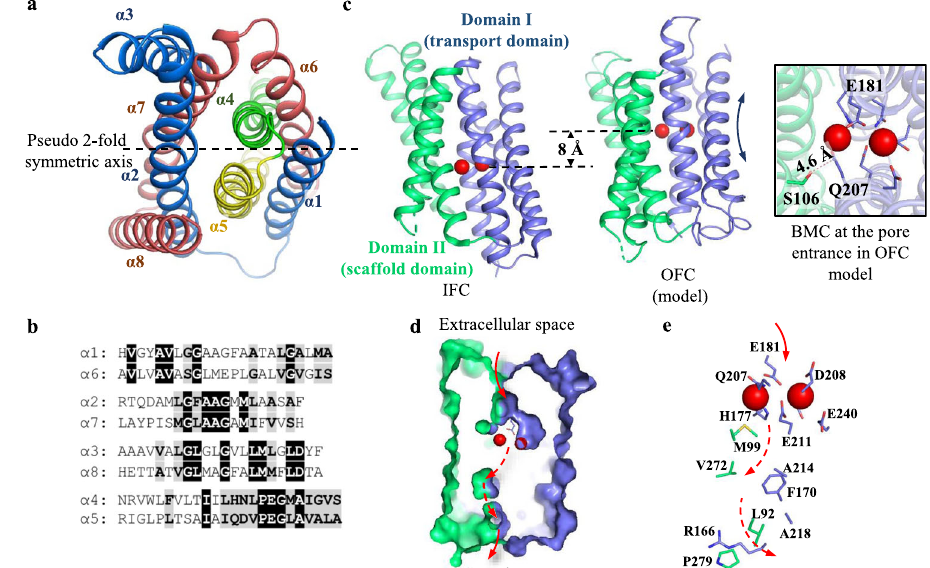
Fig. 6 | The OFC structural model generated by repeat-swap homology mod- eling.a TwopairsofinvertedrepeatsinthestructureofBbZIP. α 1- α 3(blue)and α 6- α 8 (dark pink) are symmetrically related by the two-fold pseudo symmetric axis (dashed line). α 4 (green) and α 5 (yellow) are also related by the same axis. b Sequencealignment of the symmetrically relatedTMs. c Comparison of the OFC model and the IFC of BbZIP (PDB entry ID: 5TSA). The metals are depicted as red spheress. Structures are aligned via Domain II (green). The BMC moves up by approximately 8Å when BbZIP switches from IFC to OFC. The inset shows the top view of the entrance of the transport pathway where S106 approaches Q207 to